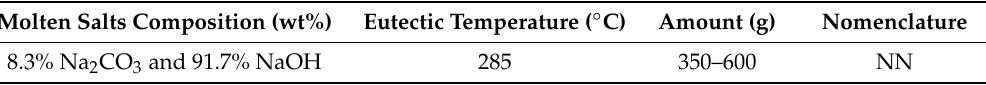
Table 1. Composition and properties of the molten